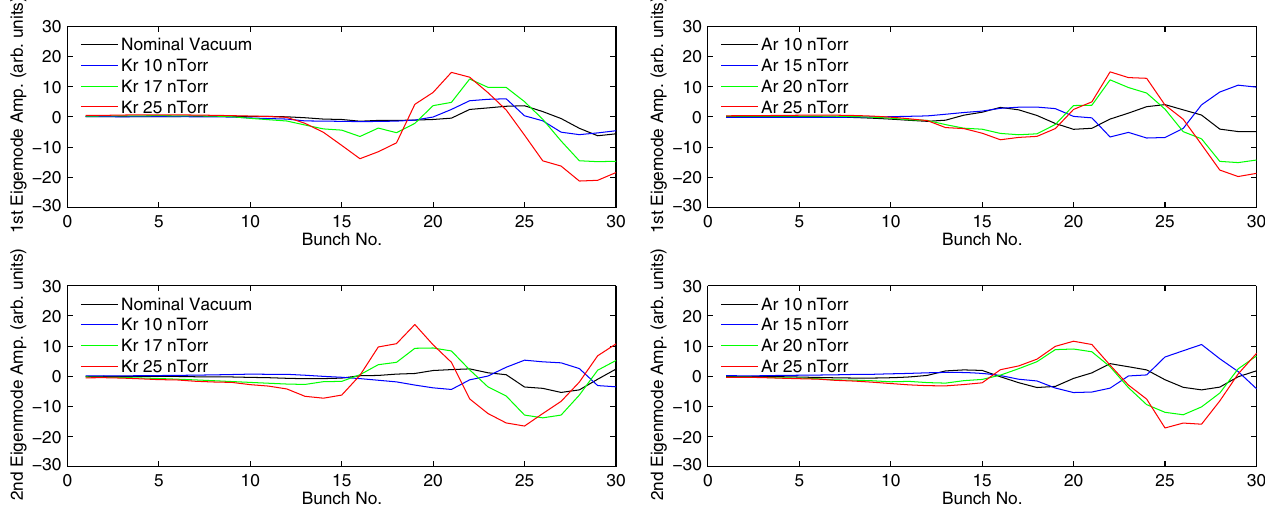
FIG. 3. Top two spatial eigenmodes (spatial eigenmodes being a representation of ion oscillations) at different pressures.